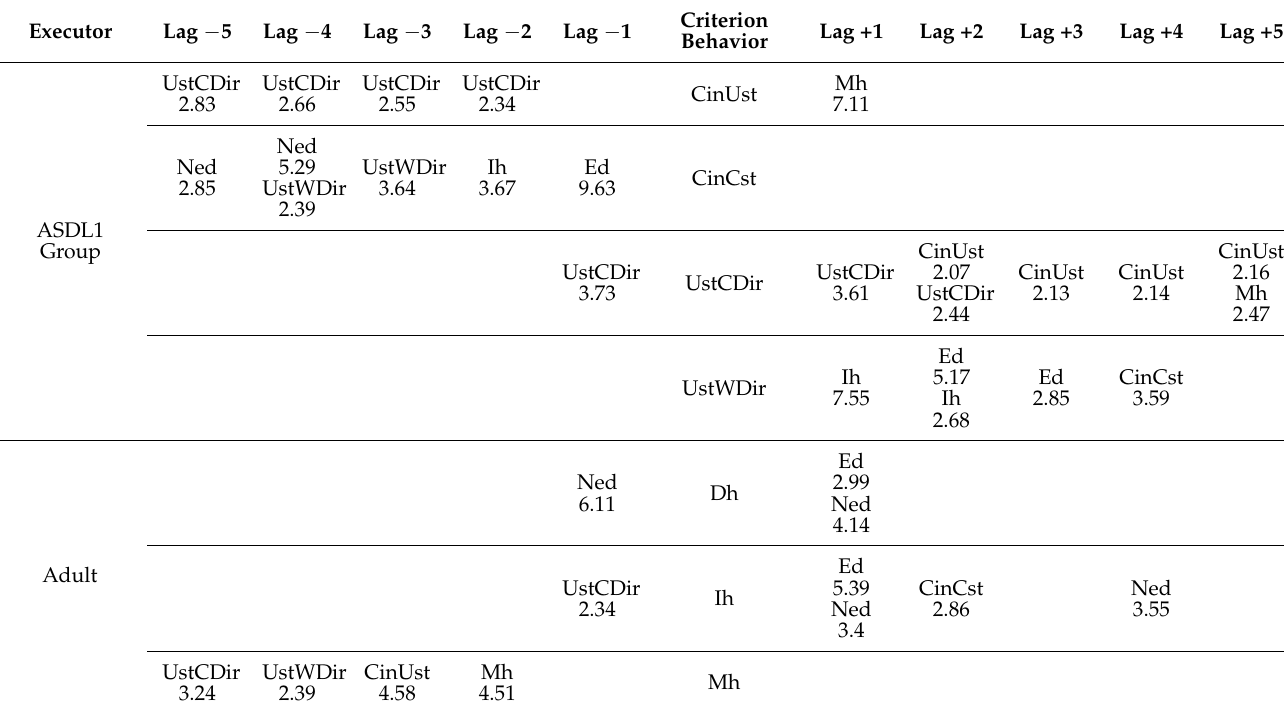
Table 5. Behavioral patterns obtained in the ASDL1 Group one month after the intervention finished (post-intervention task). Central column = It contains the criteria behaviors. Remaining cells = They contain the conditional behaviors. Numbers = Significant adjusted residuals values. Green codes = The most relevant behaviors indicating children progress in interference control. Red codes = The most relevant wrong interference control behaviors of the children. Blue codes = The most relevant adult scaffolding